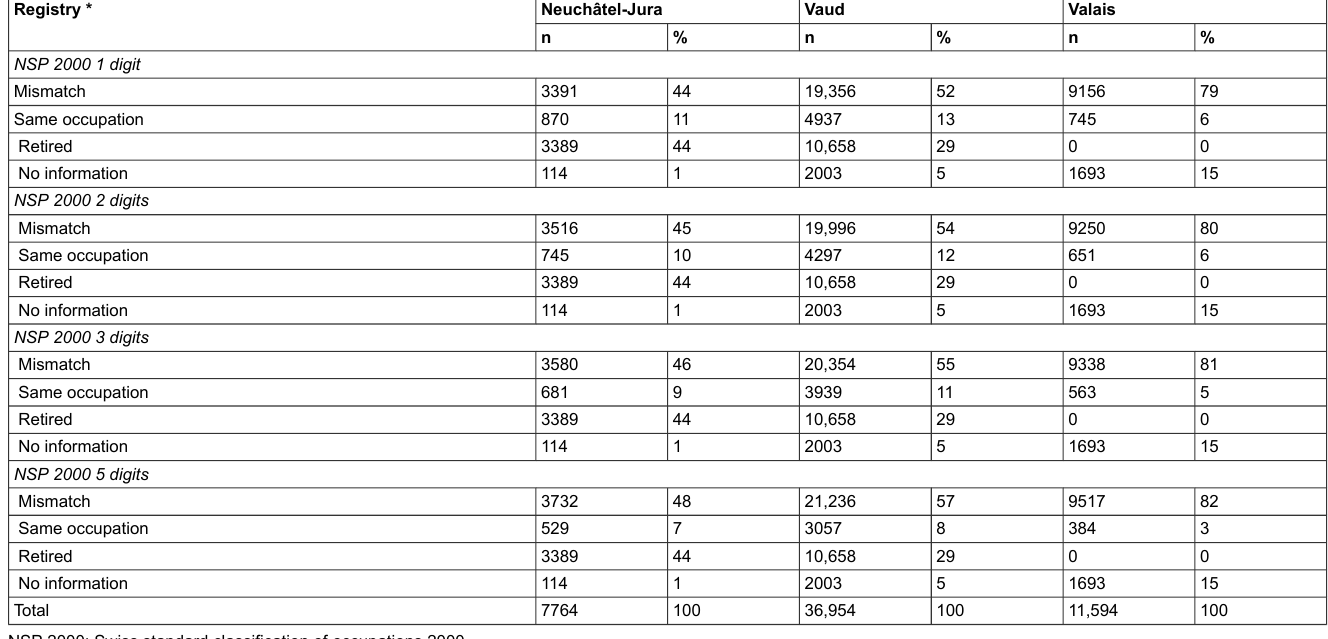
Table 3: Comparison of coded occupational information in the cancer registries of Western Switzerland between 1996 and 2004 with that of the Swiss National Cohort in the 2000 federal census. Registry *